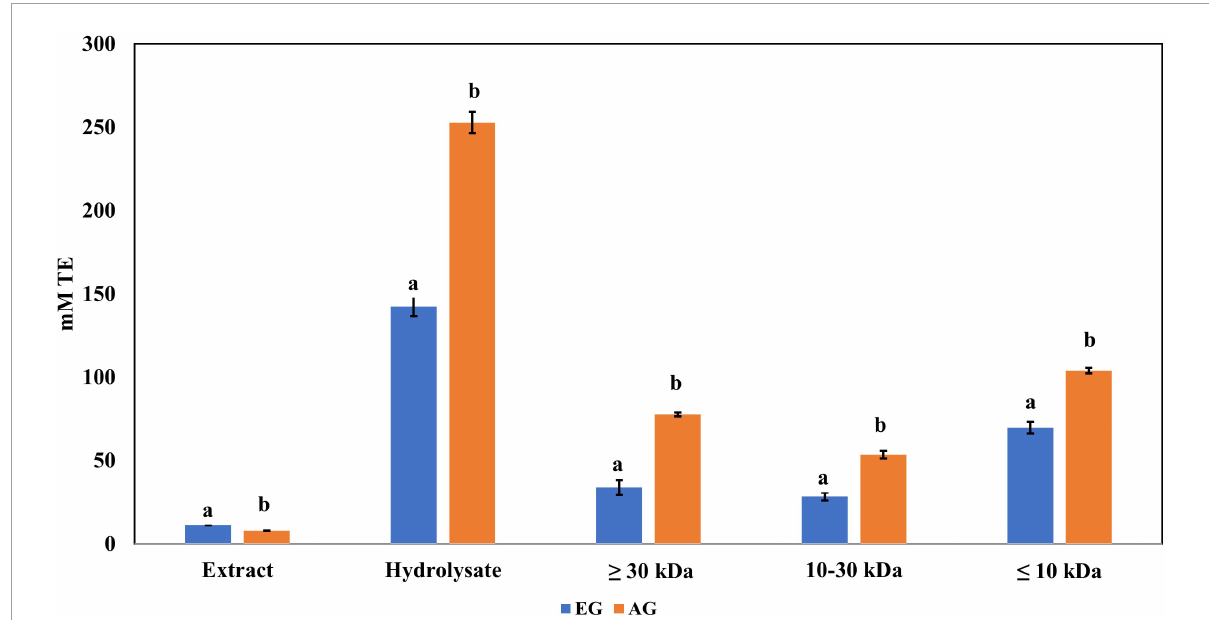
FIGURE3 Antioxidant activity against 2,2 (cid:48) -azino-bis(3-ethylbenzothiazoline-6-sulphonic acid) (ABTS) radical of extracts, hydrolysates, and hydrolyzed fractions of early grasshopper (EG) and adult grasshopper (AG). Results obtained are reported in millimolar trolox equivalents (mM TE)/gram dry weight. Different letters between bars indicate significant difference ( p -value <